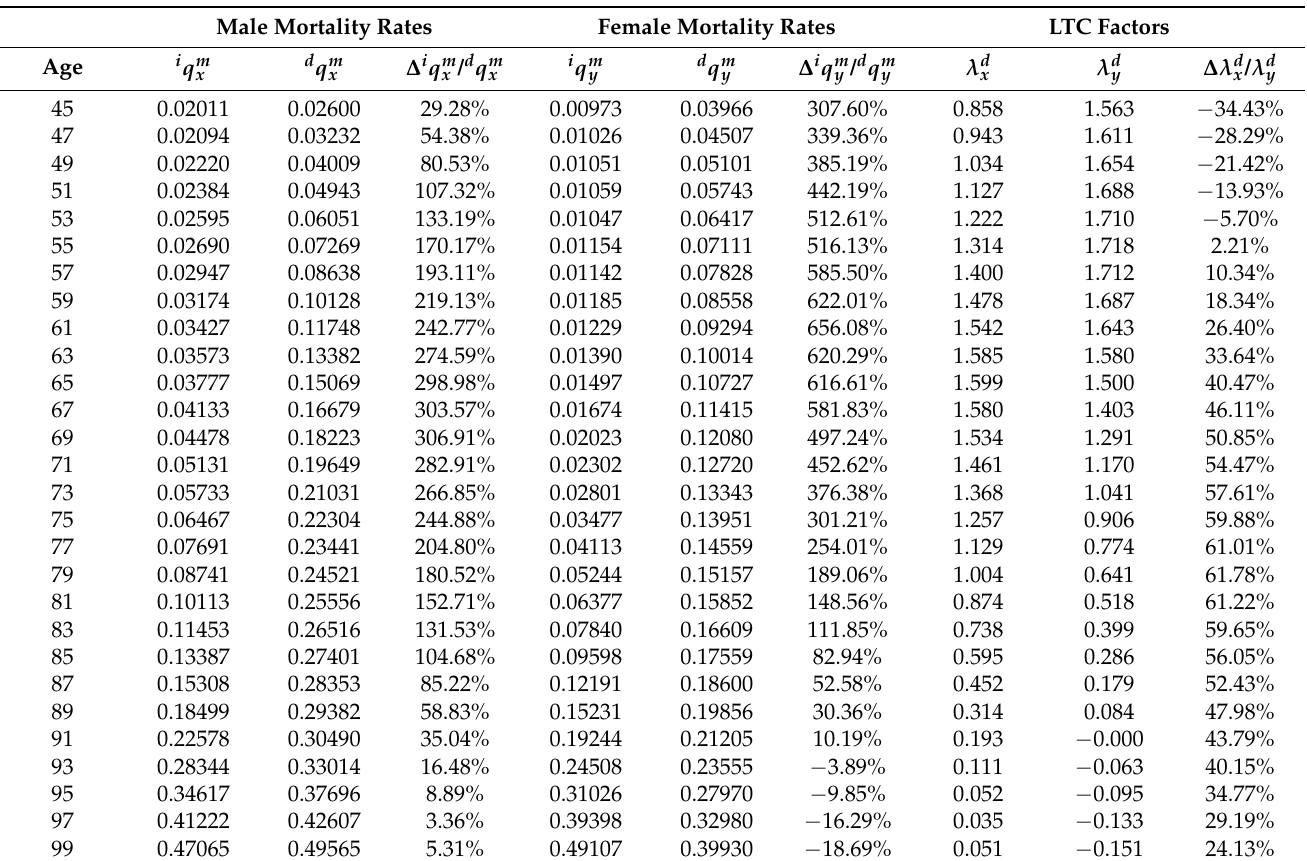
Table 3. Disability outcomes for the generation born in 1960. Source: Own work. Software